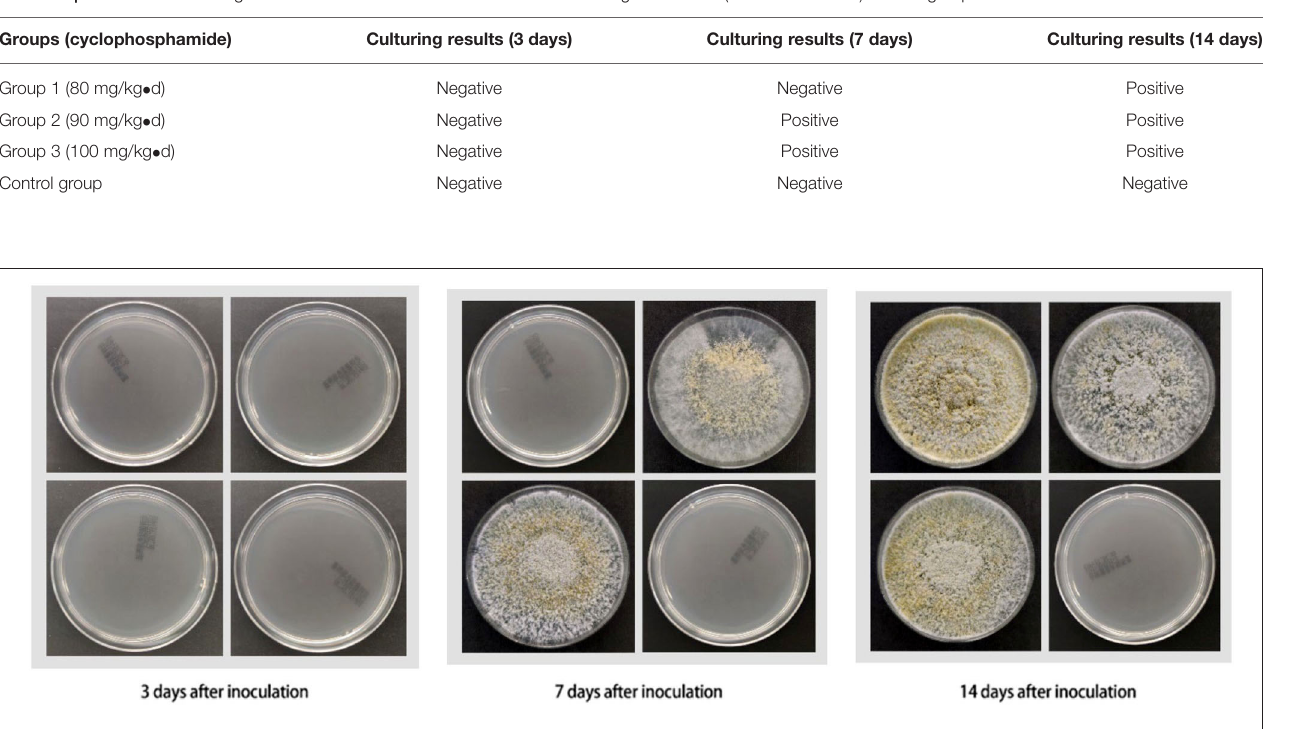
FIGURE 2 | Results of fungal culture of mouse skin tissues (all cultured for 1 week) (from left to right and top to bottom: Group 1, Group 2, Group 3, control group).